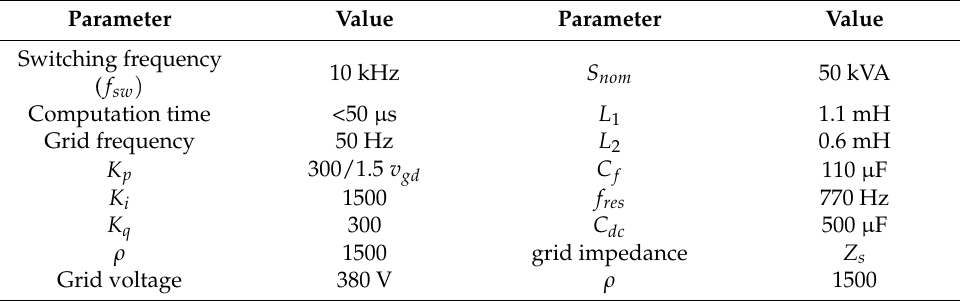
Table 3. The test system parameters.